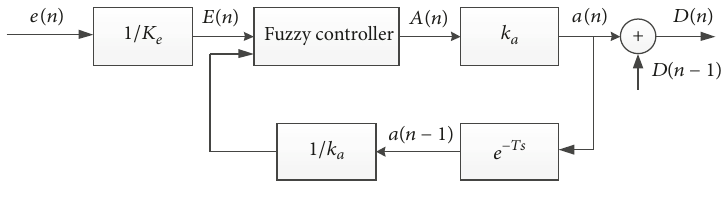
Figure 4: Fuzzy controller.